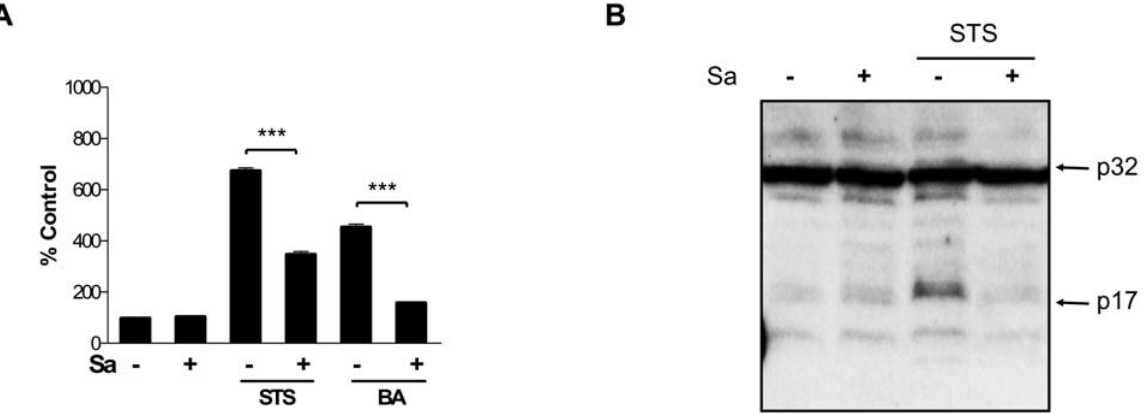
Figure 4. hMDMs infection with S.aureus inhibits caspase-3 activation induced by STS and butyric acid. ( A ) The effect of S. aureus infection on caspase-3 activity was measured with DEVD-AFC as a substrate in hMDMs after 24 h stimulation with STS or BA. The diagram is a representative result of an experiment performed in triplicate using macrophages isolated from a single donor. Bars represent mean 6 SD of caspase-3 activity (RFU/min). The caspase-3 activity of mock-infected cells was regarded as 100%. ( B ) Inhibition of procaspase-3 processing induced by STS in S. aureus -infected hMDMs. Macrophages with or without S. aureus infection were STS treated, and 24 h post-infection cells were lysed for Western Blot analysis using antibodies against caspase-3. Caspase-3 antibody staining was developed with a secondary antibody conjugated to horseradish peroxidase followed by visualization using ECL as described in the Materials and Methods.